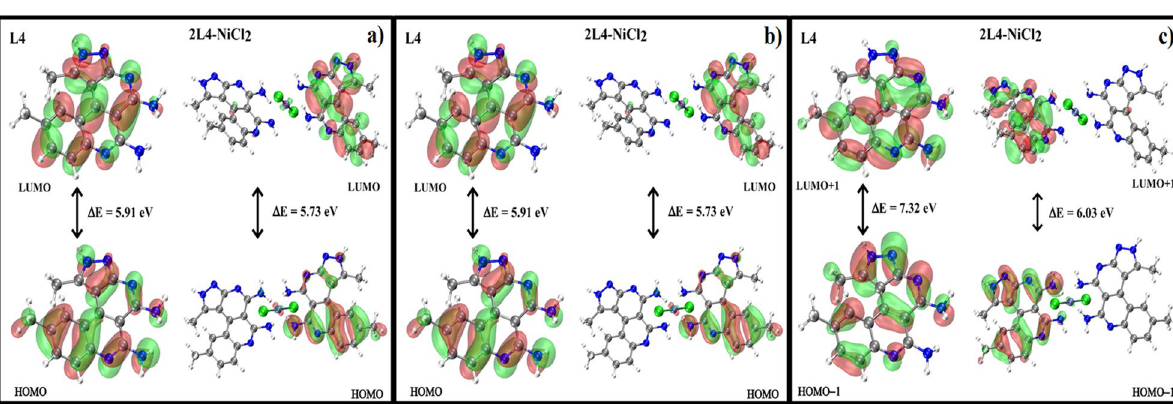
Figure 11. ( a ) FMO surfaces plot. HOMO and LUMO for L4 (left) and 2L4-NiCl 2 (right), ( b ) FMO surfaces plot. HOMO-1 and LUMO + 1 for L4 (left) and 2L4-NiCl 2 (right), ( c ) FMO surfaces plot. HOMO-2 and LUMO + 2 for L4 (left) and 2L4-NiCl 2